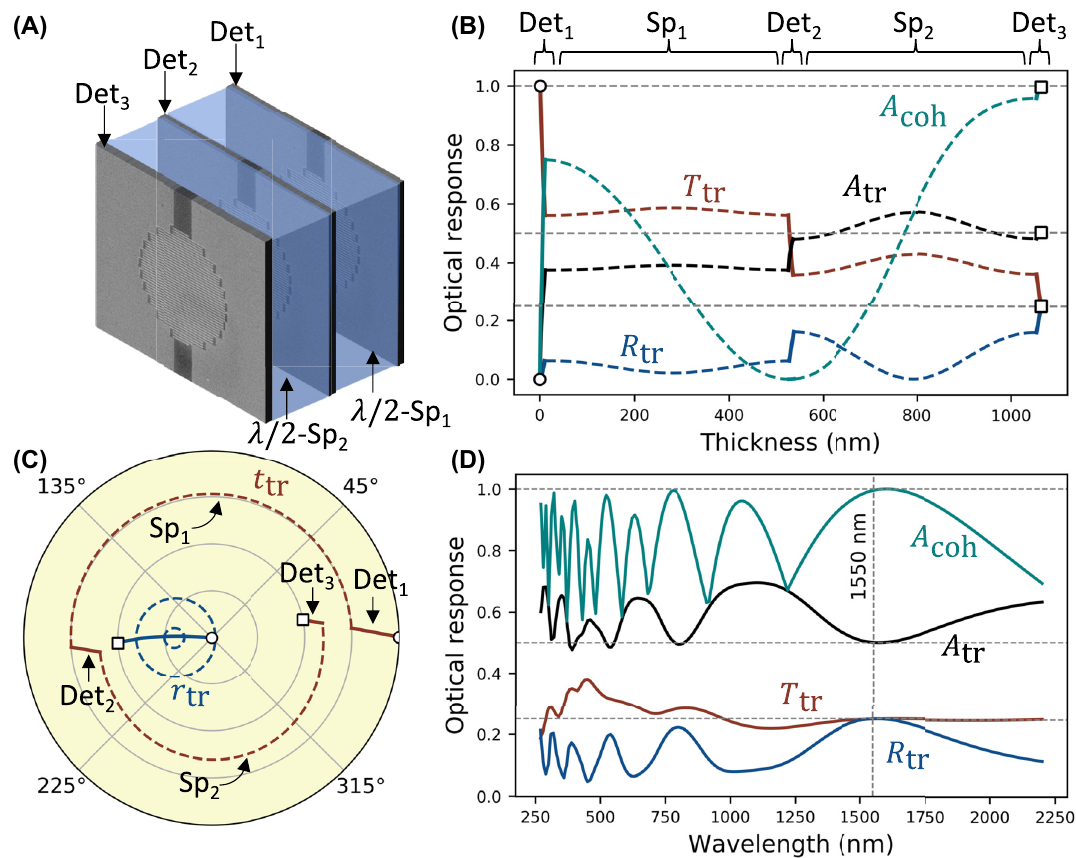
Figure 4: Three-layer distributed detector. (A) Distributed detector consists of three nanowire layers – Det and Sp . The intensity (B) and amplitude (C) coefficients are evaluated continuously as layers are deposited, starting with Det 2 (dashed) lines correspond to the deposition of the nanowire layers (spacers). Empty circles and squares mark the beginning and end of the deposition. (D) The spectrum of the entire